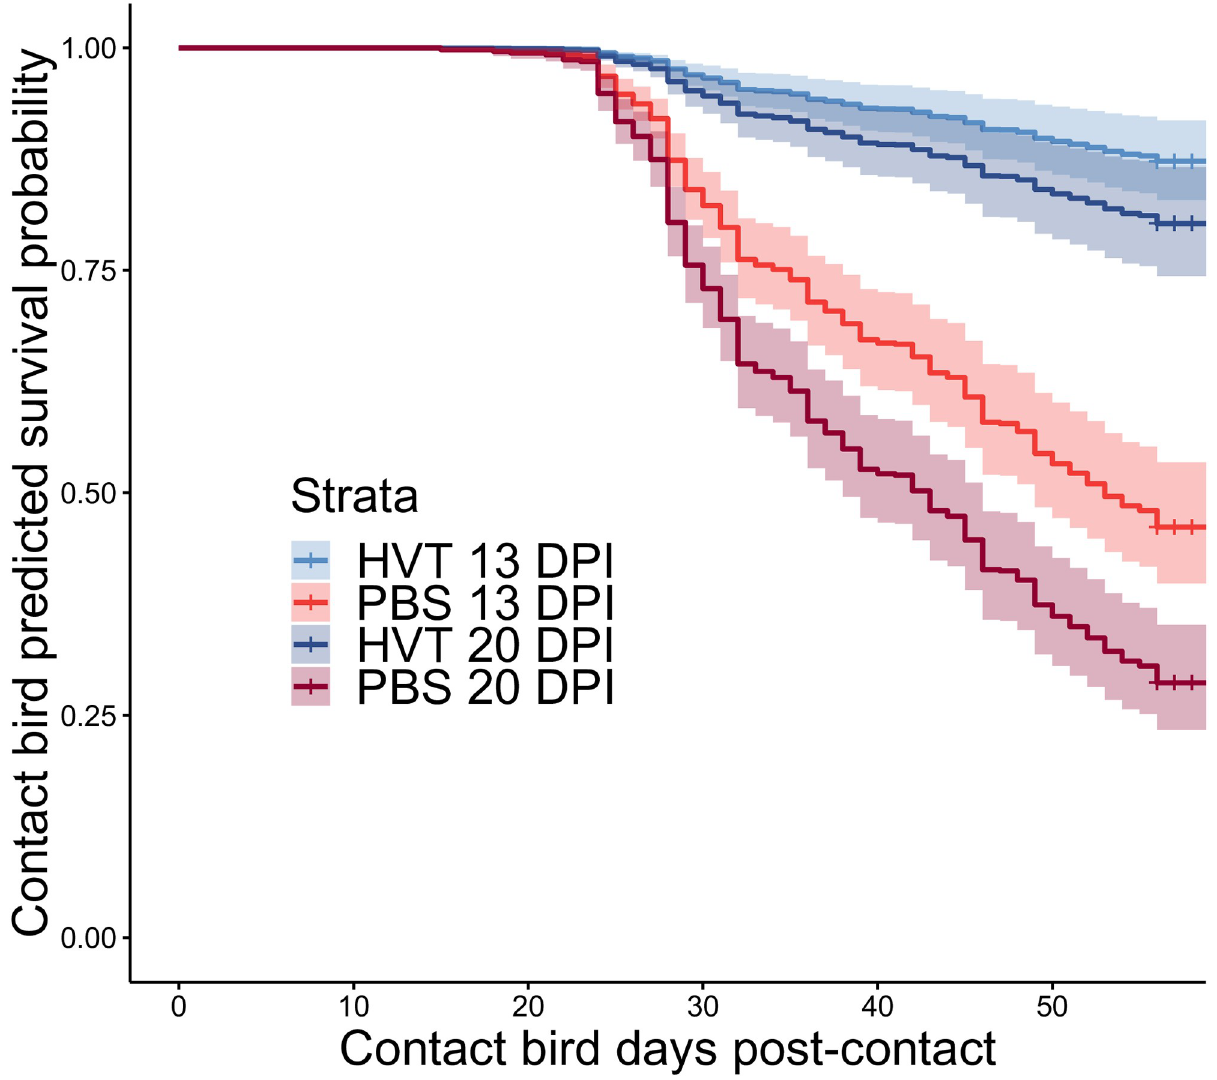
Fig 3. Cox proportional hazards estimated survival probability curves for all combinations of shedder vaccination status and DPI. Shaded areas represent 95% confidence intervals. HVT = vaccinated shedders; PBS = sham-vaccinated shedders. Note that all mortality up to 7 DPC was assumed to be chick mortality unrelated to MD, and these individuals were excluded from all analyses. Underlying data are in Edinburgh DataShare repository (https://doi.org/10.7488/ds/2725). DPI, days post-infection; DPC, days post-contact; HVT, herpesvirus of turkeys; MD, Marek disease.